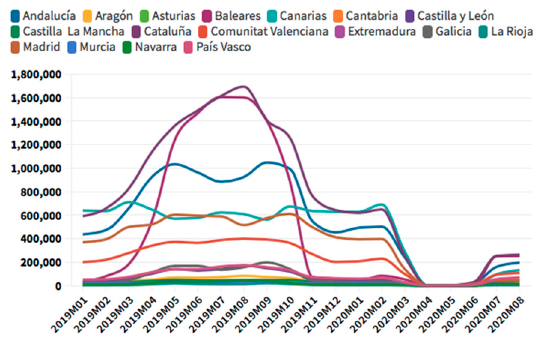
Figure 5. International tourism hotel occupancy. Source: Own elaboration from INE data.